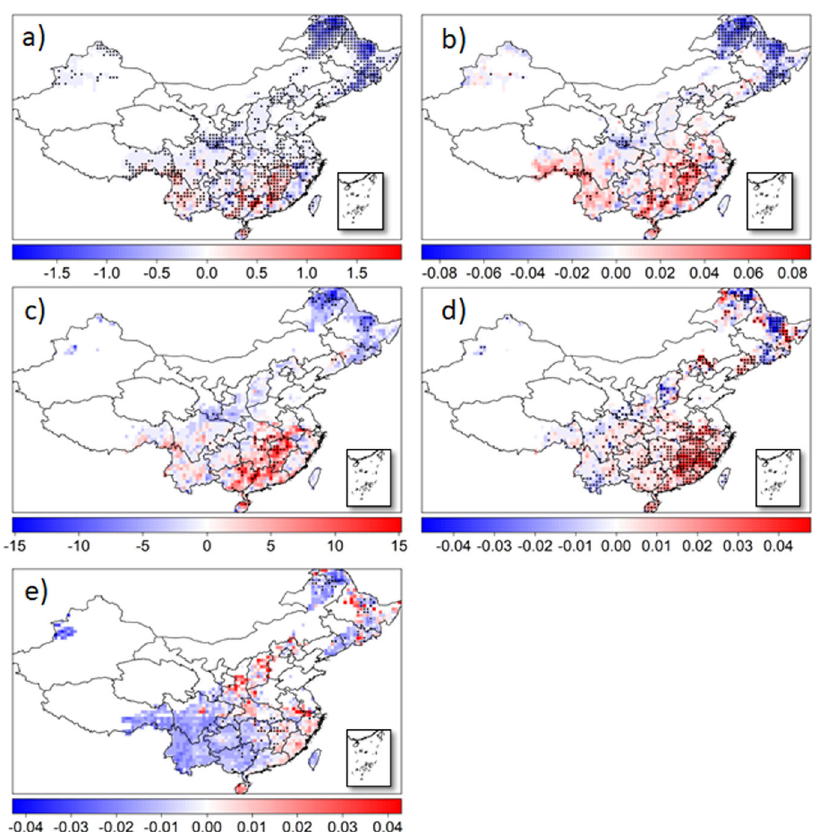
Fig. 3 Spatial patterns of trends for disturbance regimes within each 0.5° grid cell across China ’ s forests. ( a ) total annual disturbed forest area (km 2 yr − 1 ), ( b ) percent of forest disturbed annually (% yr − 1 ), ( c ) disturbance frequency (# of patches per 1000km 2 forest), ( d ) mean patch size (ha yr -1 ), and ( e ) fi re severity ( Δ NDVI yr -1 , delta Normalized Difference Vegetation Index). Points indicated a signi fi cant trend at 0.05 levels for disturbance